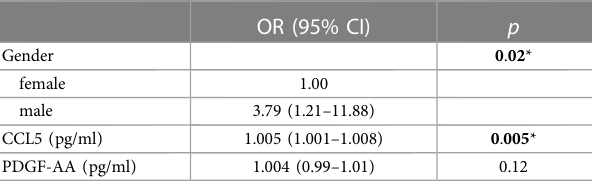
TABLE 2 Analysis of in fl uencing factors in children with